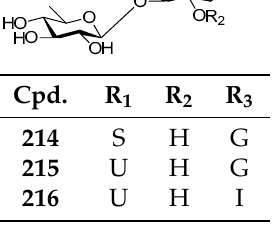
Figure 34. Structures of compounds 214 – 216 .